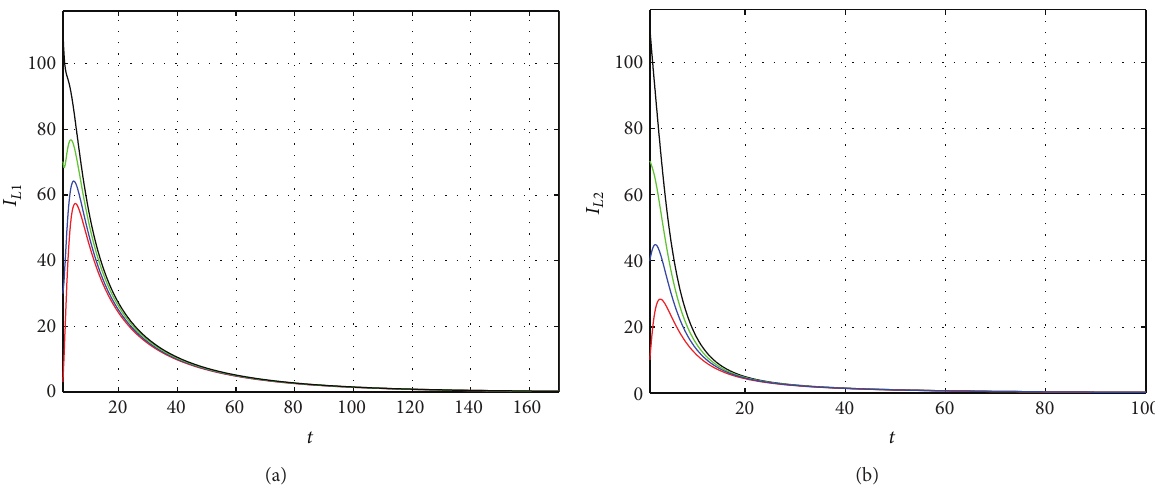
Figure 4: Time series of echinococcosis disease 𝐼 𝐿𝑖 , 𝑖 = 1, 2 , when the two patches are connected with 𝐷 1 = 0.8 , 𝐷 2 = 0.2 .